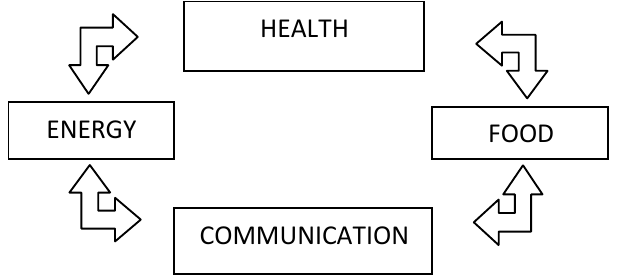
Figure 1: Global Capitalism. Basic